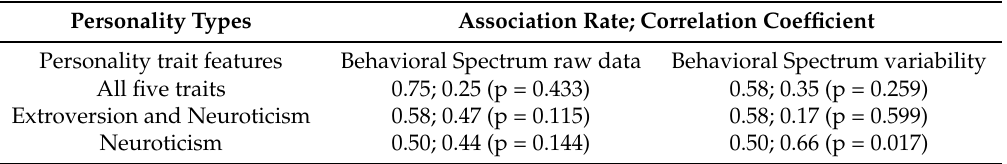
Table 4. Association between personality traits and user activity trials in HS data obtained during the morning period.